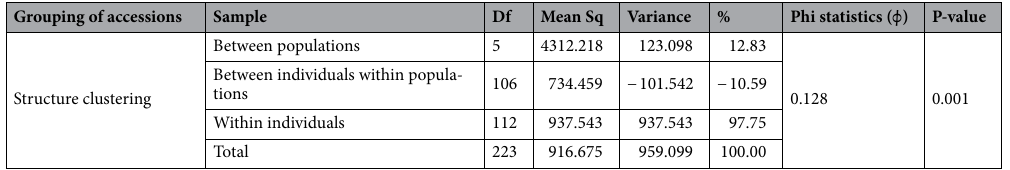
Table 3. Analysis of molecular variance (AMOVA) of 112 Luffa acutangula accessions. Df degrees of freedom, Sq square.